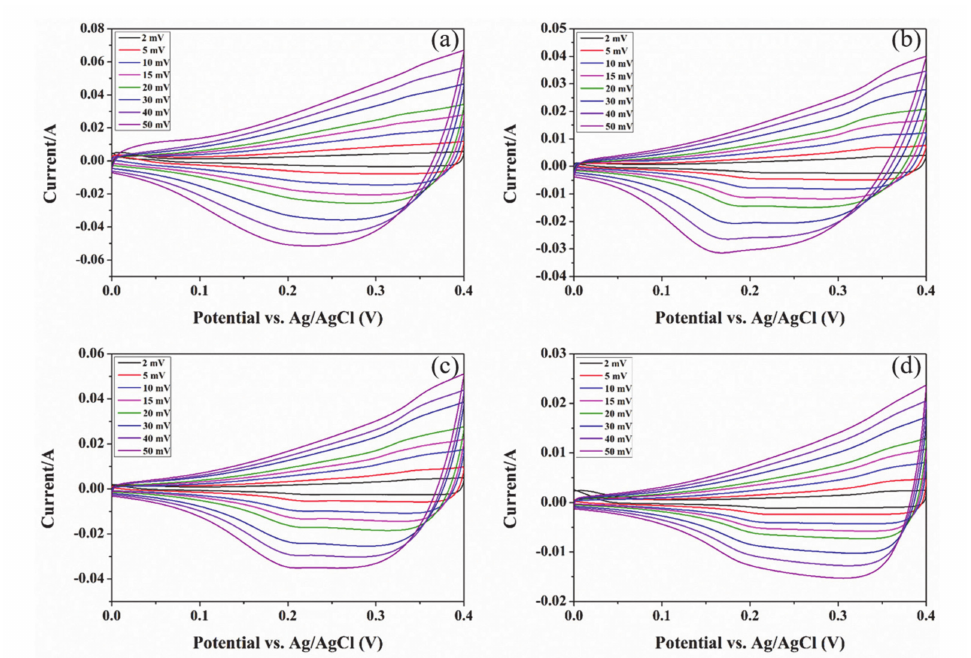
Figure 5. Cyclic voltammetry (CV) at di ff erent scan rates of the CuO / Cu foam prepared via di ff erent anodizing temperature ( a ) 25, ( b ) 40, ( c ) 60, and ( d ) 80 ◦ C. The specific capacitance of the CuO / Cu foam electrodes were calculated according to Equation (5).